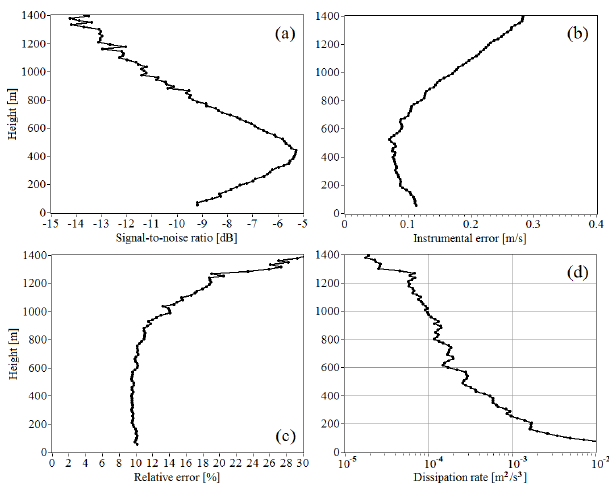
Figure 8. Vertical profiles of signal-to-noise ratio (a) , instrumental error of radial velocity estimate (b) , relative error of estimation of the turbulent energy dissipation rate (c) , and turbulent energy dis- sipation rate (d) retrieved from measurements from 17:40 to 18:20 on 20 July